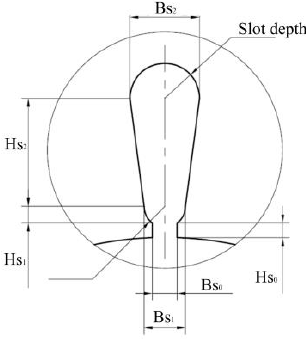
Figure 5. Design parameters of the stator slot. Table 1. Basic geometrical size of the PMSM motor.